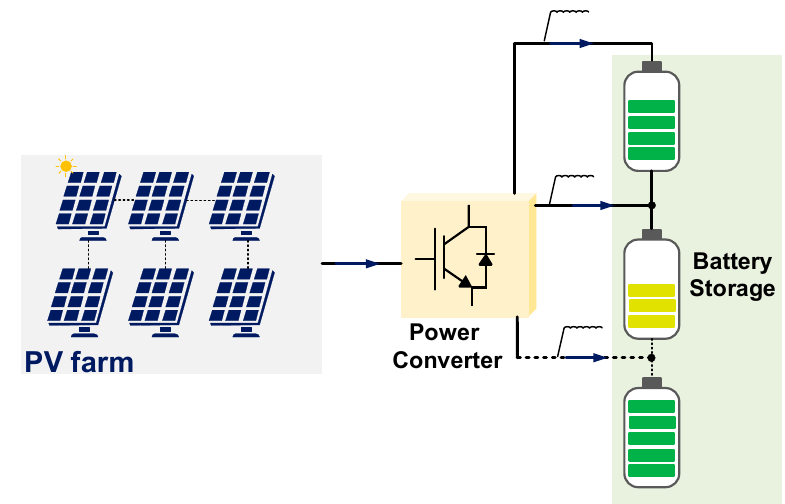
Figure 3. Power transfer from PV modules to the battery storage system.